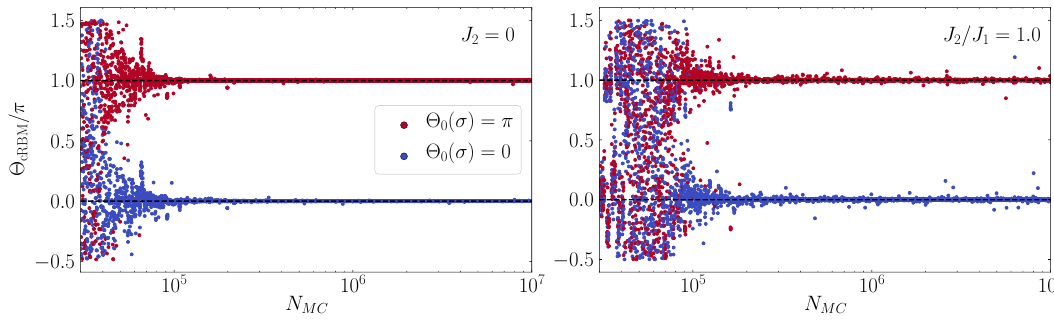
( σ ) for the cRBM wave function with α = 1 c cRBM = 0 (left panel) and J / J = 1 (right 2 2 1 and the variational parameters are updated every MC